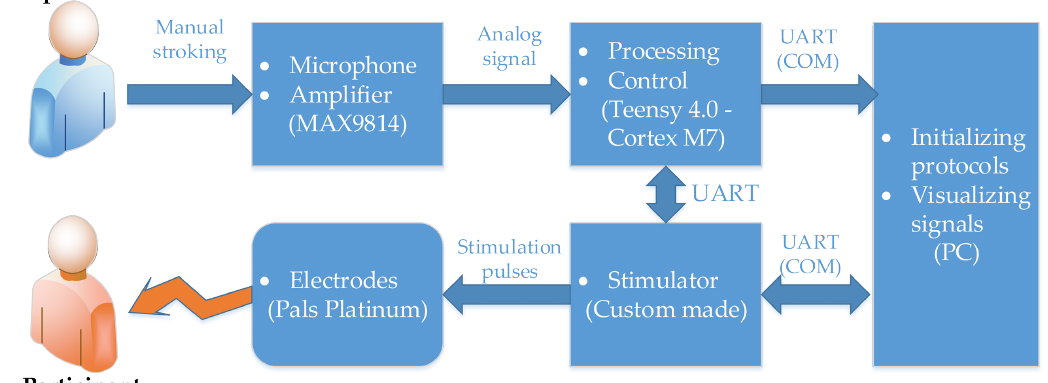
Figure 2. System overview. The manual stroking was performed by the experimenter with an omnidirectional electret microphone with the integrated amplifier. The audio signal was digitized by a Teensy 4.0 microcontroller for further signal processing and signal features extraction. The calculated median frequency was then sent to the custom-made electrical stimulator through a Universal Asynchronous Receiver/Transmitter (UART) connection. The electrical stimulation was then delivered through self-adhesive Pals electrodes attached to the participant’s forearm skin over the median nerve. Both, Teensy and the stimulator were communicating with a PC using their UART